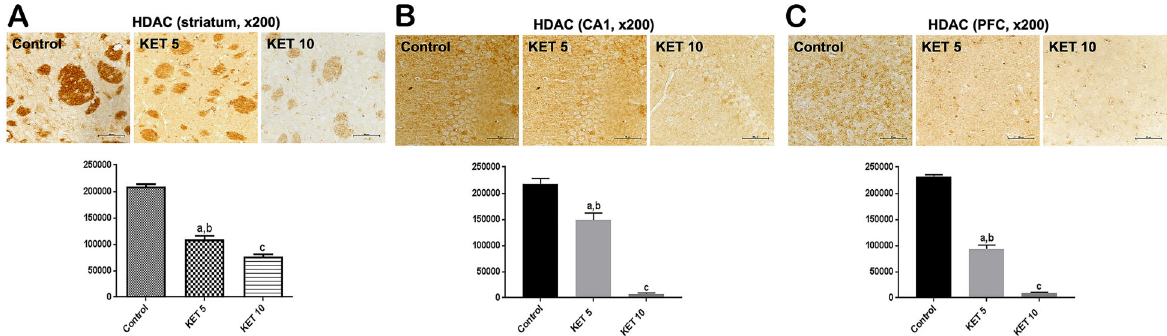
Figure 4. Single administrations of ketamine (KET, 5 and 10 mg/kg, ip ) signi fi cantly reduced histone deacetylase (HDAC) immunoreactivities in the A ) striatum, B ) CA1 hippocampal sub fi eld, and C ) prefrontal cortex (PFC) compared with controls (3 animals per group). Representative photomicrographs, at (cid:1) 200 magni fi cation (50 m m), taken at D1 protocol. The graphs show the relative absorbance determined by the ImageJ software (NIH, USA). Data are reported as means ± SE. a,b P o 0.01 vs Control; c P o 0.01 vs KET 5 (one-way ANOVA and Tukey as the post hoc test).